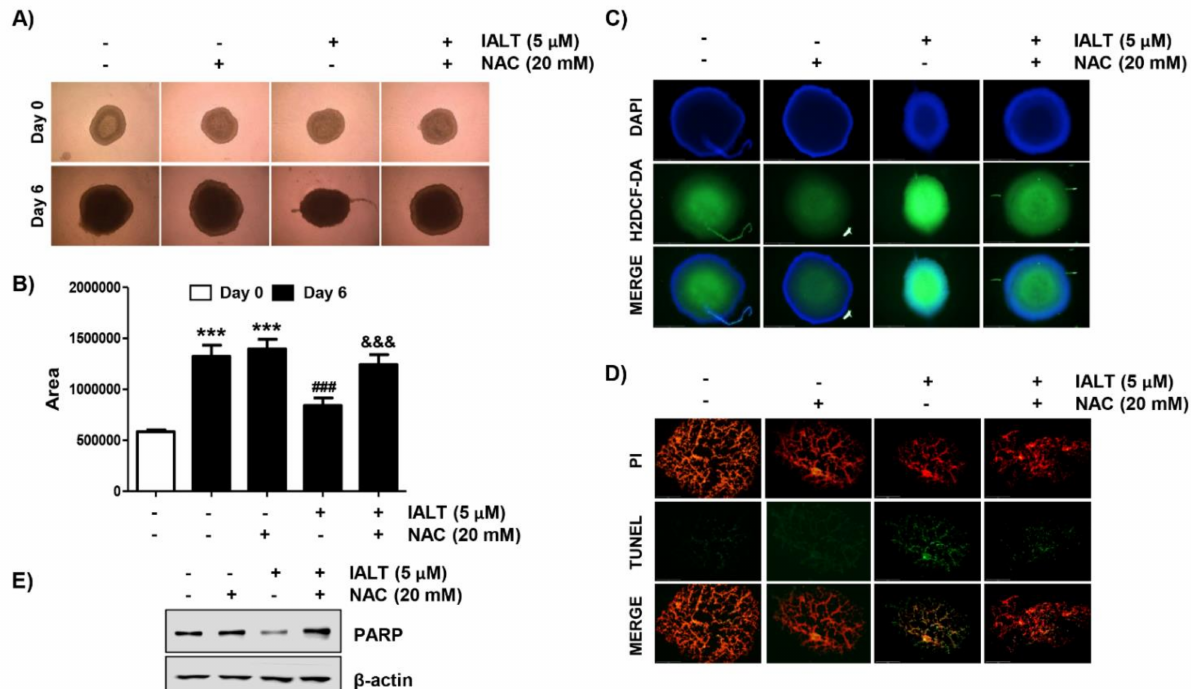
Figure 5. Effects of IALT on Hep3B cell growth in 3D spheroid model. Spheroids were formed for 3 days and treated with 5 µ M IALT for 6 days or pre-treated with or without 20 mM NAC for 1 h and then treated with 5 µ M IALT for further 6 days. ( A ) The images of representative spheroids obtained under a phase-contrast microscope on the final day of treatment (9 days after cell seeding) are presented. Images were taken at 200 × magnification. ( B ) The spheroid size was calculated using Image J software. Data are expressed as the mean ± SD (*** p < 0.001 compared to day 0 spheroids. ### p < 0.001 compared to untreated spheroids. &&& p < 0.001 compared to 5 µ M IALT-treated spheroids). ( C ) Spheroids were stained with DCF-DA, and the generation of ROS was observed under a fluorescence microscope, and representative fluorescence micrographs depicting ROS generation are presented. ( D ) The sections of spheroids were stained using the TUNEL apoptosis detection kit and then observed under a fluorescence microscope. Images were taken at 400 × magnification. ( E ) The levels of PARP were analyzed by Western blot analysis. β -actin was used as the loading